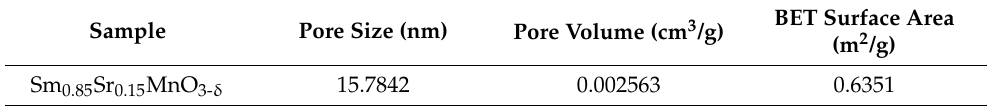
Table 2. Pore size, pore volume, and BET surface area of the sample. Sample Pore Size (nm) Pore Volume (cm 3